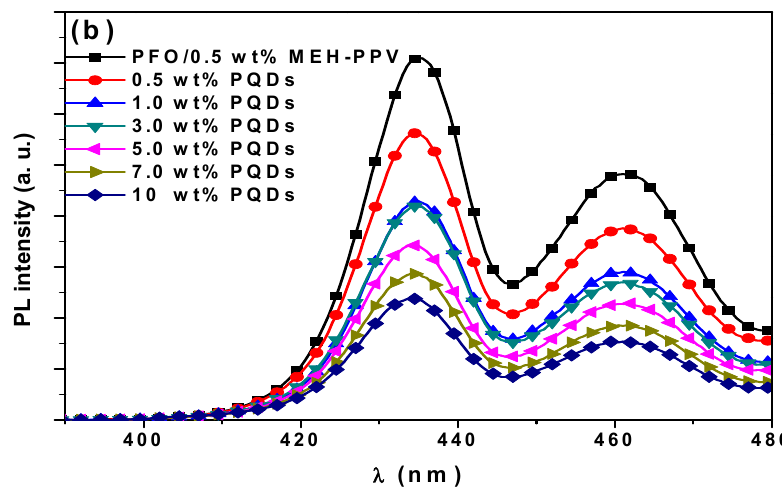
Figure 4. ( a ) Normalized emission intensity of the hybrid thin fi lms of PFO/MEH-PPV with various PQD contents, ( b ) emission intensity of the hybrid thin fi lms of PFO/MEH-PPV with various PQD contents in the range 390–480 nm.